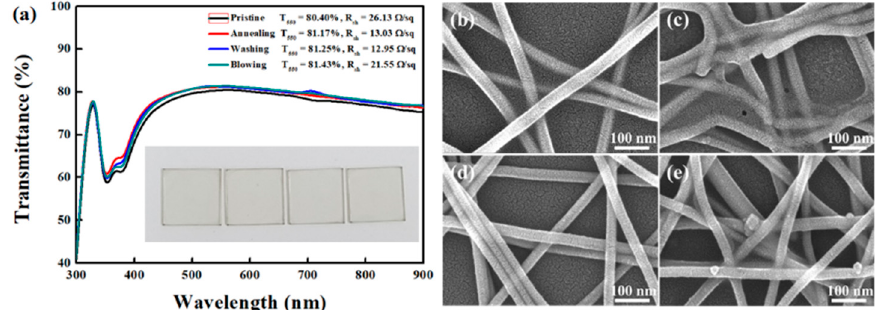
Figure 2. ( a ) Optical transmittance and sheet resistance of thick Ag NWs network with various post treatment. Inset is a photograph of a thick Ag NWs network. ( b – e ) SEM images of a thick Ag NWs network followed by different post-treatment. ( b ) SEM images of the pristine thick Ag NWs network, ( c ) thick Ag NWs network after thermal annealing at 130 °C for 20 min, ( d ) thick Ag NWs network after solvent dipping, and ( e ) thick Ag NWs after N 2 gas-blowing.